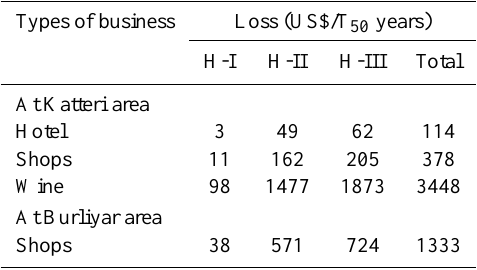
Fig. 4. Risk curve for total direct risk (A) and total indirect risk (B) , expressed in monetary value